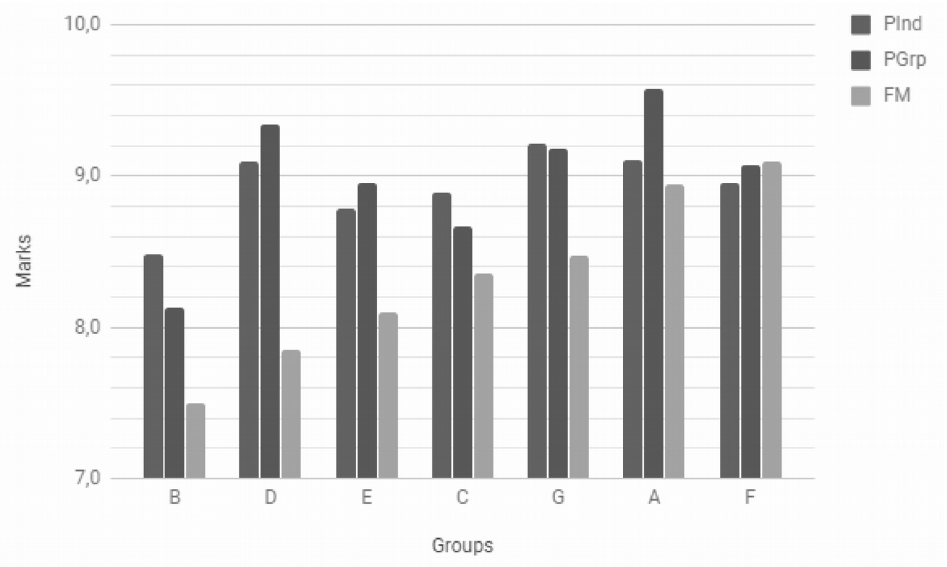
Figure 2. Marks, ordered by FM